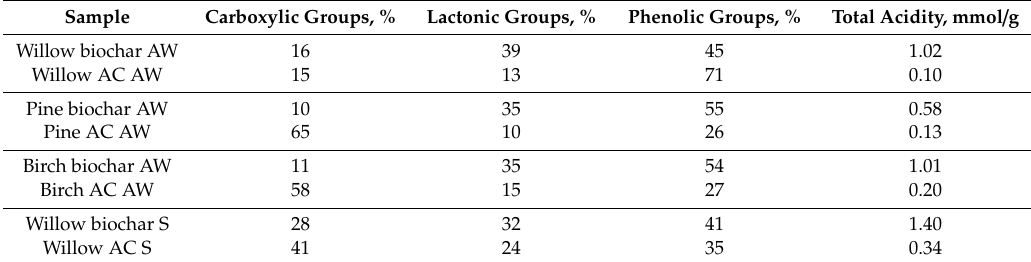
Table 3. The surface oxygen group results of the biochars and ACs.